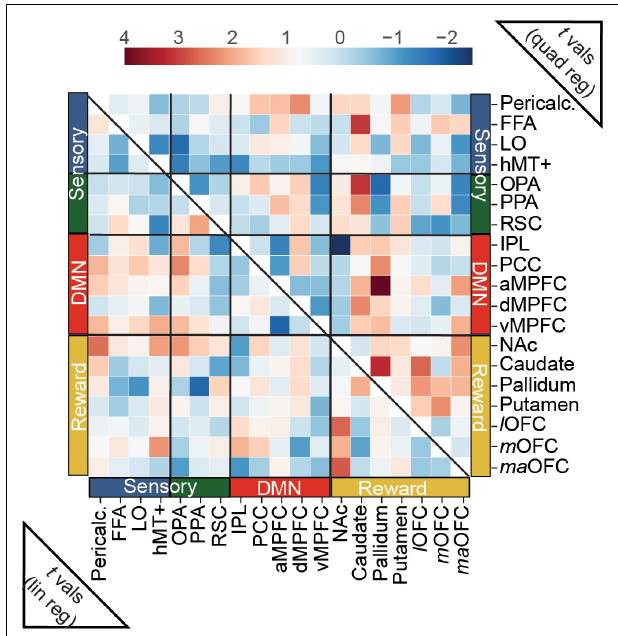
FIGURE 5 | Predicting trial-wise functional connectivity estimates between a priori ROIs from visual, reward and DMN networks. FC scores were computed between each pair of a priori ROIs, separately for each movie stimulus, and modeled as a function of overall aesthetic ratings using both linear and quadratic regressors. Heat maps show t -scores from group level one-sample t -tests, conducted with the t -scores from the regressions for each edge. For the linear effect of aesthetic appeal (lower half), FC modulations were observed mainly between nucleus accumbens (NAc) and sensory ROIs and NAc and OFC ROIs (see text). For the quadratic effect (upper half) FC modulations were found between reward and sensory ROIs, between reward and DMN ROIs and within reward ROIs. N = 24. No scores were significant at q < 0.05 corrected for multiple-comparisons (false-discovery rate). One edge, (pallidum:aMPFC quadratic) was less than p < 0.001